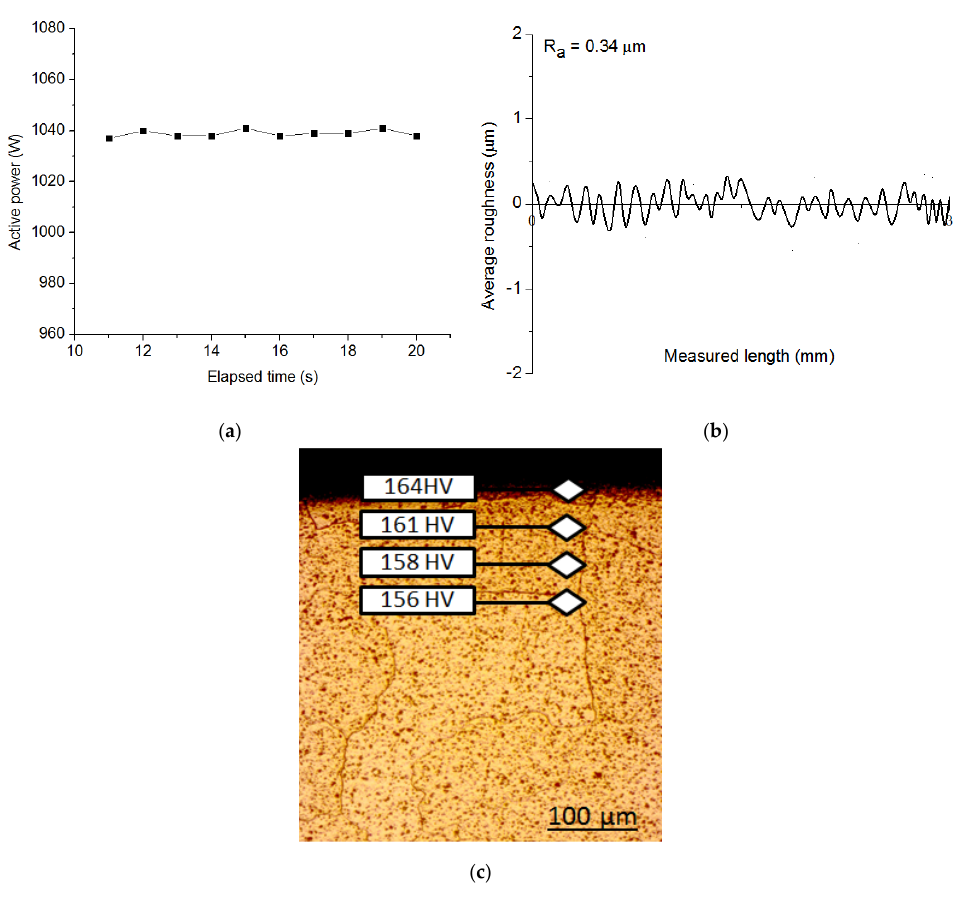
Figure 5. The main effects of machining parameters on energy efficiency.